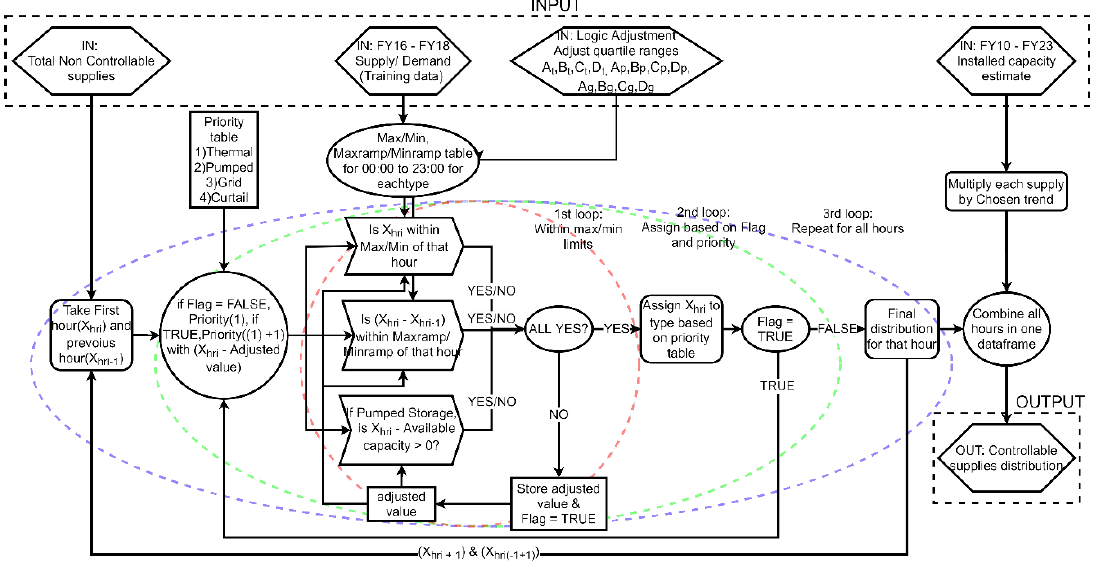
Figure 7. Logic method flowchart.